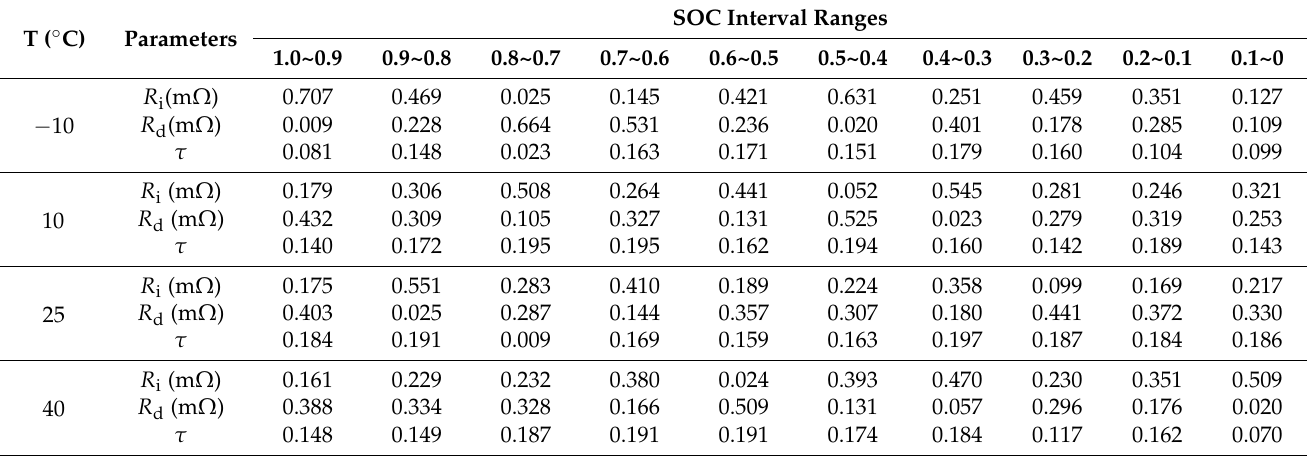
Table 3. Parameter identification results of ultracapacitor for different SOC intervals and temperatures.